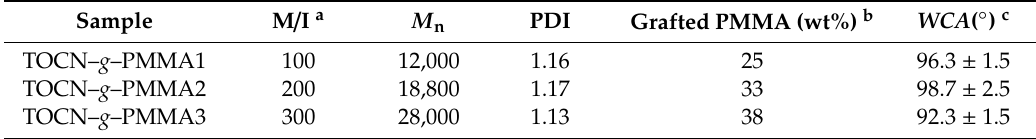
Table 2. Conditions and characterization of surface-initiated initiators for continuous activator regeneration atom transfer radical polymerization (SI ICAR ATRP) of methyl methacrylate (MMA) from TOCN–Br.